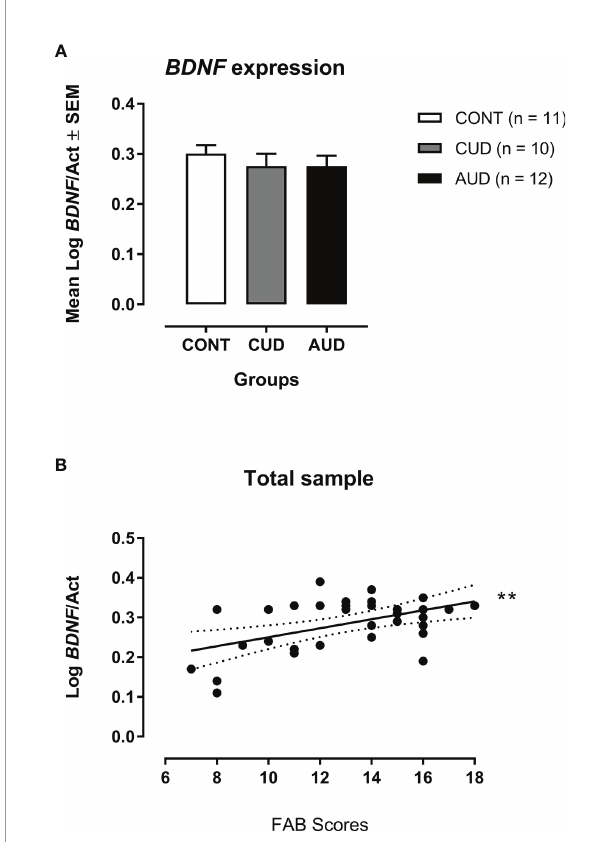
FIGURE 1 | (A) Mean Log BDNF/Act values from both CUD (n = 10) and AUD (n = 12) patients compared to the mean of the control group (CONT, n = 11). Smaller Ct values re fl ect earlier threshold cycle, that is, the quantitative cycle in which the target was captured is early, meaning that the target is more expressed. (B) Log BDNF/Act and FAB total scores in all subjects (controls and crack-cocaine and alcohol use disorder patients). ** p = 0.002 (Multiple Linear Regression Analysis corrected by age and schooling).